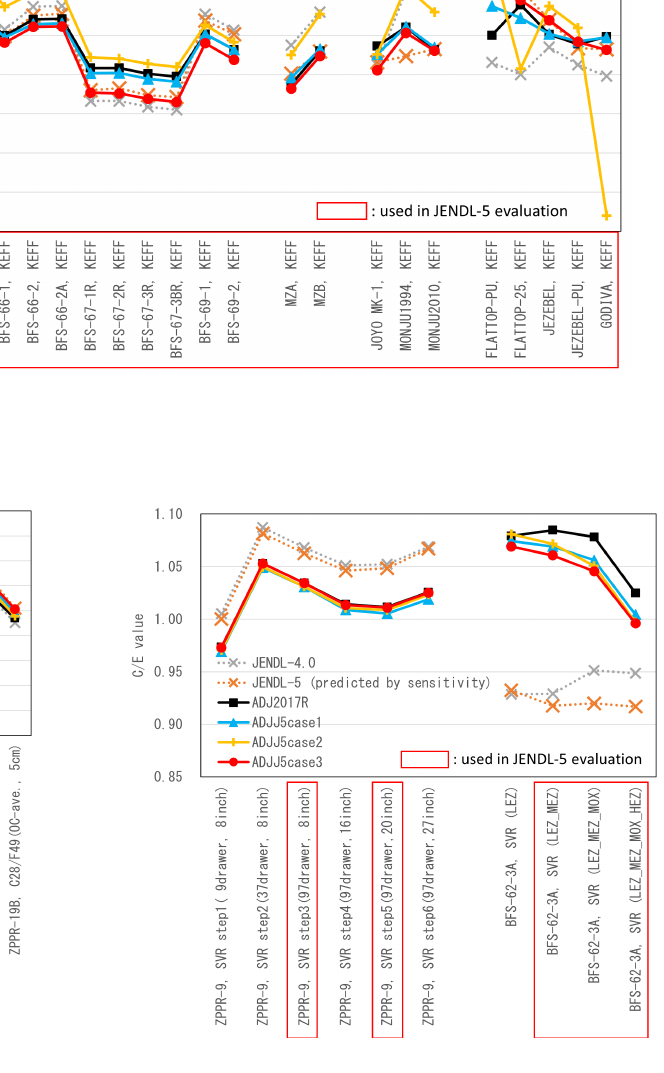
Figure 4. C / E values of sodium void